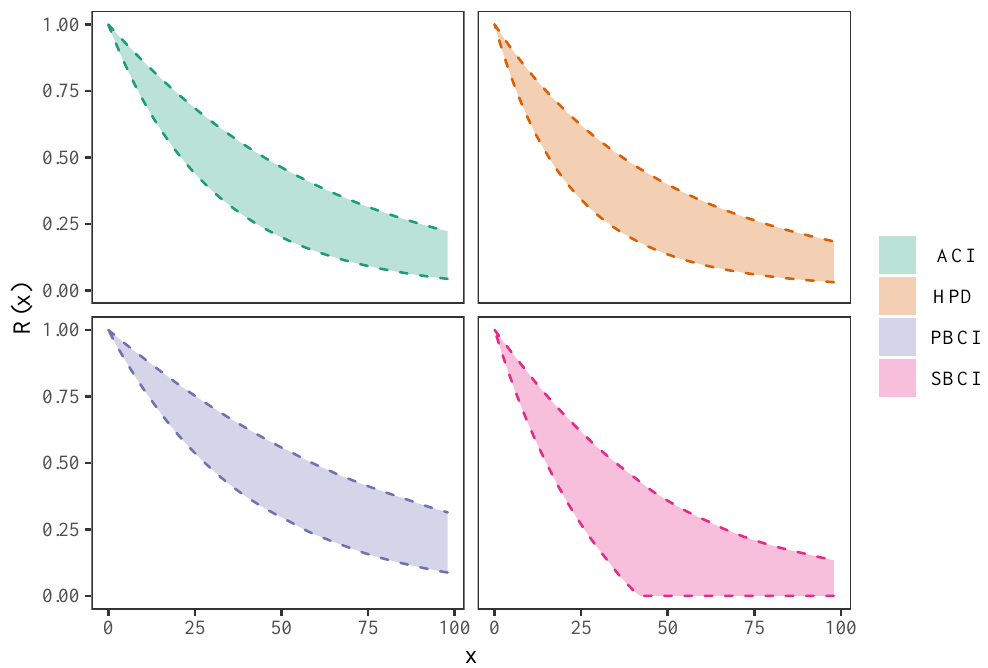
Figure 8. Interval estimates of RF R ( x ) for the real